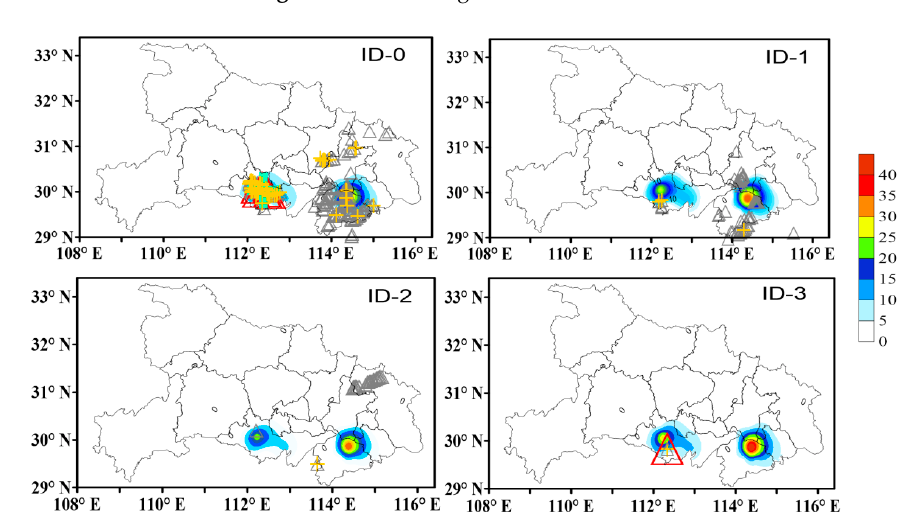
Atmosphere 2019 , 10 , x FOR PEER REVIEW Figure 5. Same as Figure 4 but for Case 2. Figure 5. Same as Figure 4 but for Case 2.